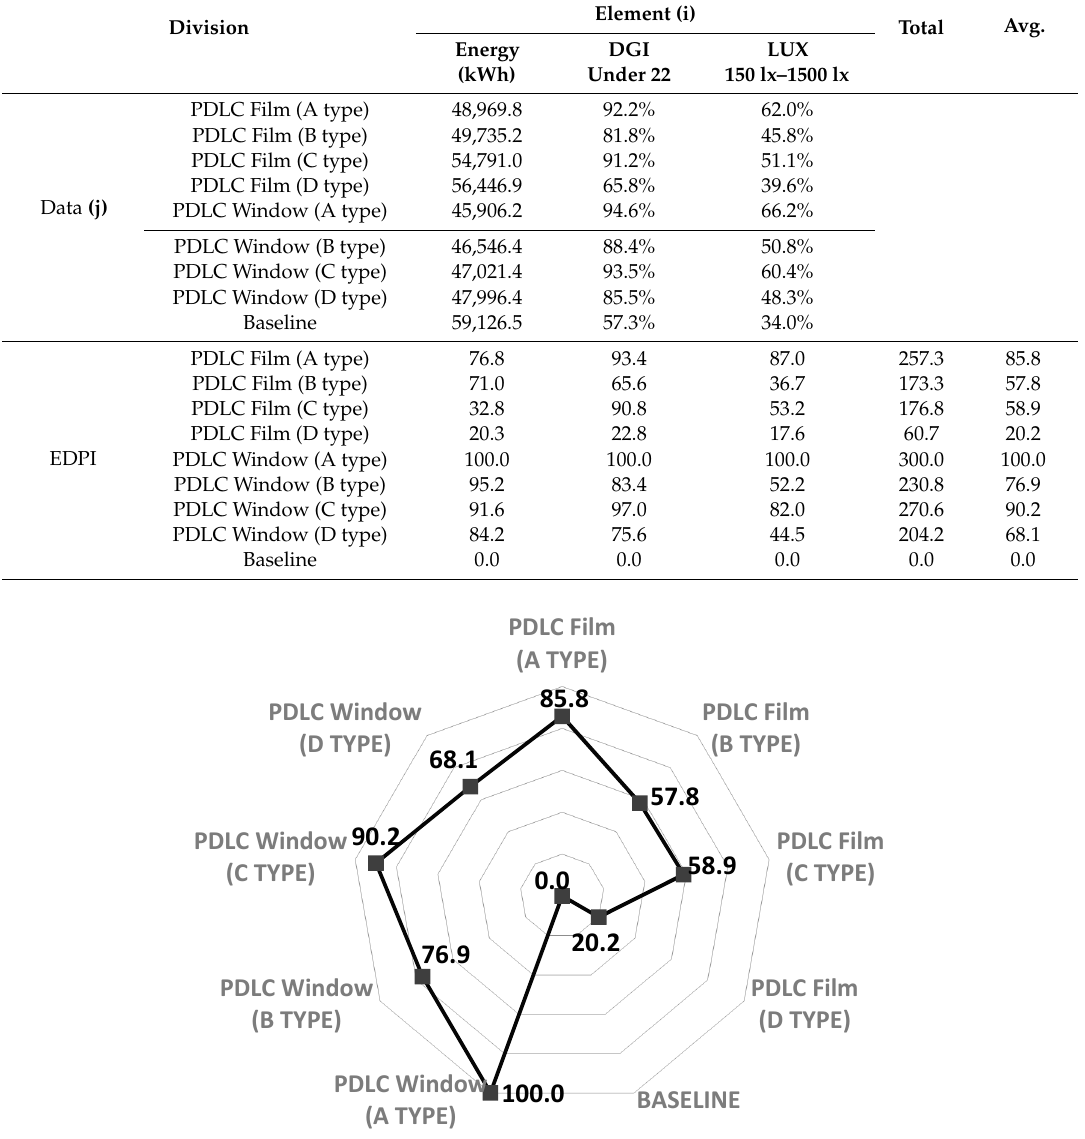
Figure 15. Integrated energy and daylight performance evaluation result through the EDPI.